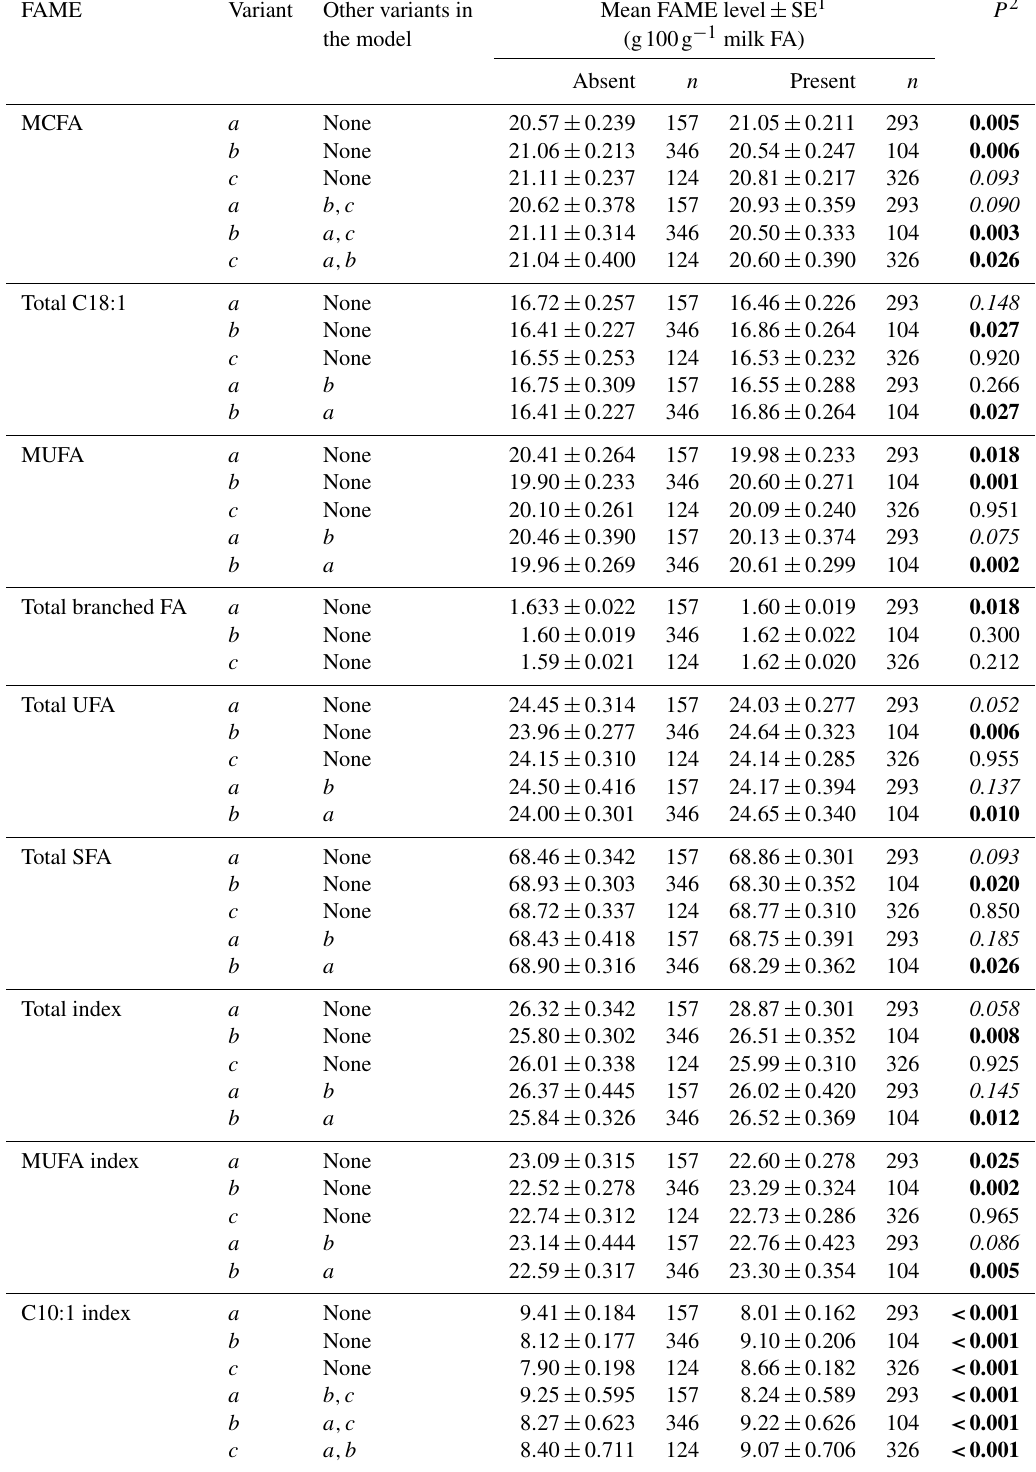
Table 4. Association between grouped fatty acid levels and SCD 3 (cid:48) -UTR variation.